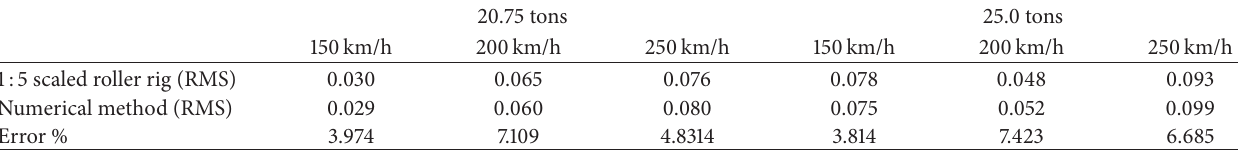
Table 3: Comparison of the RMS values for the experimental and numerical results for a vehicle horizontal acceleration of 0.37 m/s 2 .